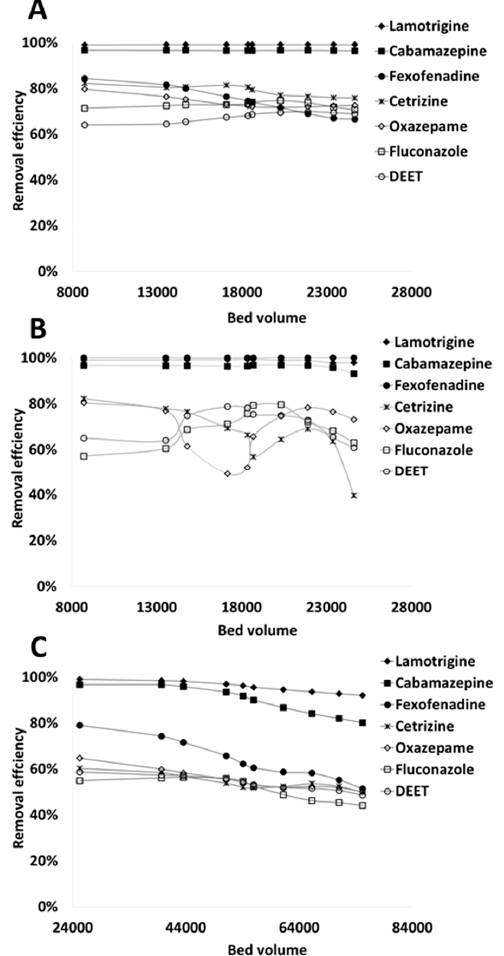
Figure 3. Removal efficiency profiles as a function of number of bed volumes for seven organic micropollutants in granulated activated carbon pilot-scale columns: ( A ) containing Norit 830W (C1-N18) and with an empty bed contact time (EBCT) of 18 min; ( B ) containing Filtrasorb 400 (C3-F18) and with EBCT of 18 min; and ( C ) containing Filtrasorb 400 (C4-F6) and with EBCT of 6 min.